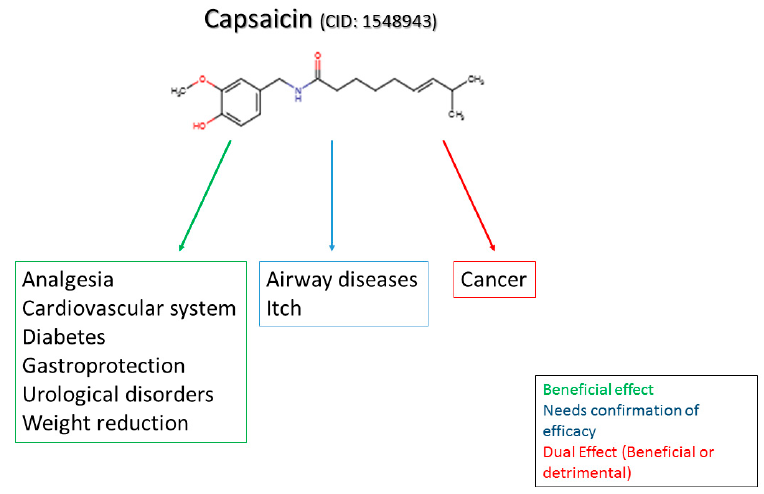
Figure 5. Summary of the current knowledge on capsaicin activities-related to diseases. Green arrow indicates the diseases in which capsaicin presents beneficial effects, and therefore, could be useful as a treatment. Blue arrow indicates diseases in which the effect of capsaicin is still controversial and the therapeutic effect of capsaicin and TRPV1 agonists and antagonists need further investigation. Red arrow indicates that capsaicin might play a role in either preventing or causing cancer.